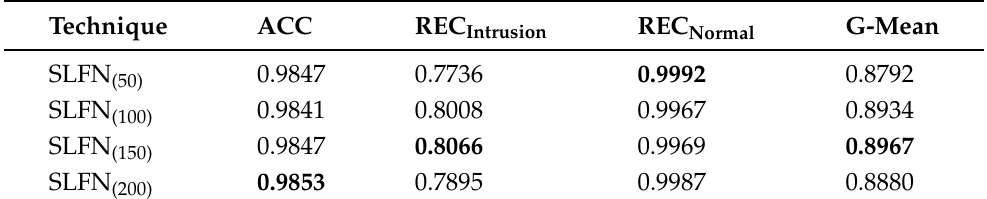
Table 3. Performing SLFN on a different number of neurons. Bold font indicates best